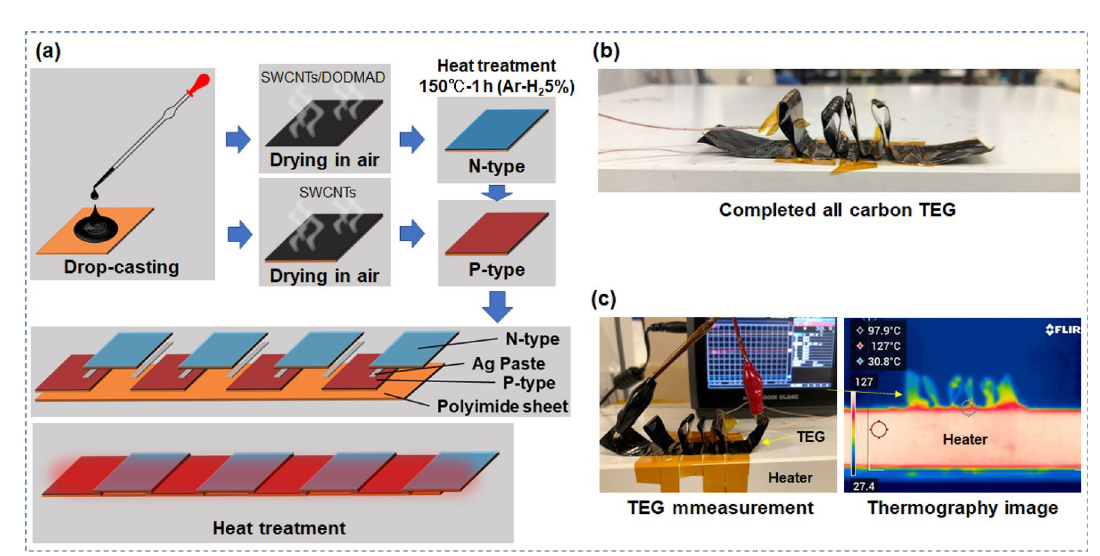
Figure 4. ( a) Fabrication process of all-carbon TEG. ( b) Photograph of completed all-carbon TEG. ( c) Photograph of performance measurement of all-carbon